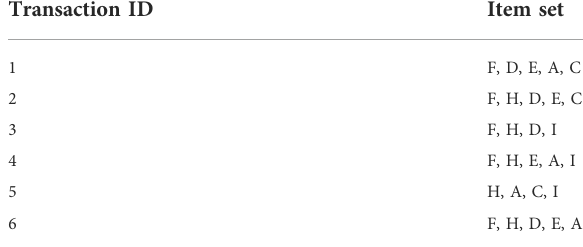
TABLE 4 Transaction set in descending order of